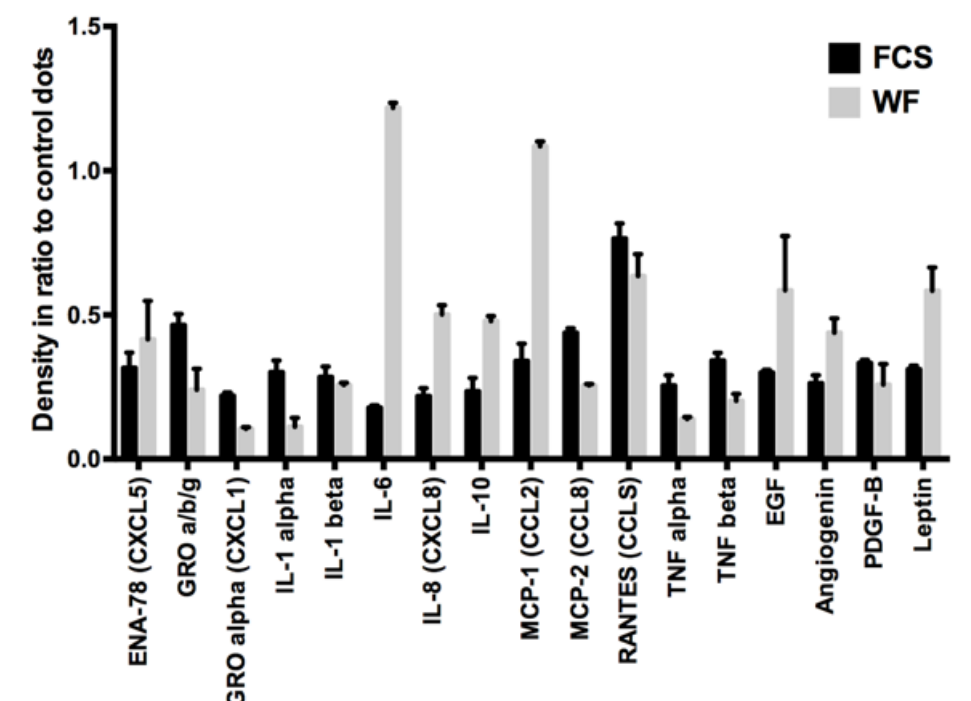
Figure 1. Semiquantitative cytokine contents analysis of pooled WF and FCS: In the WF compared with FCS, higher concentrations of IL-6, IL-8, IL-10, CCL2 (MCP-1), EGF, angiogenin, and leptin and lower concentrations of GRO, CXCL1, IL-1 α , CCL8 (MCP-2), RANTES, TNF α , and TNF β are detectable. Shown are the results of 10 pooled WF donors.